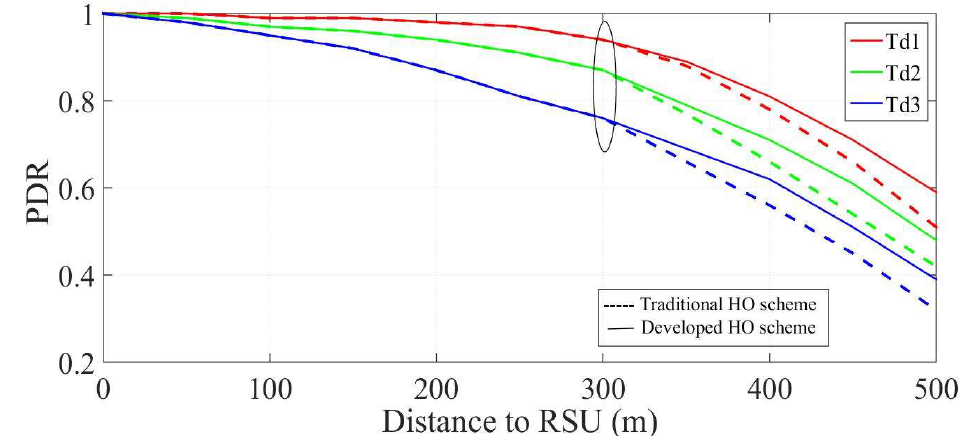
Figure 6. PDR at different traffic densities, with the distance to RSU.